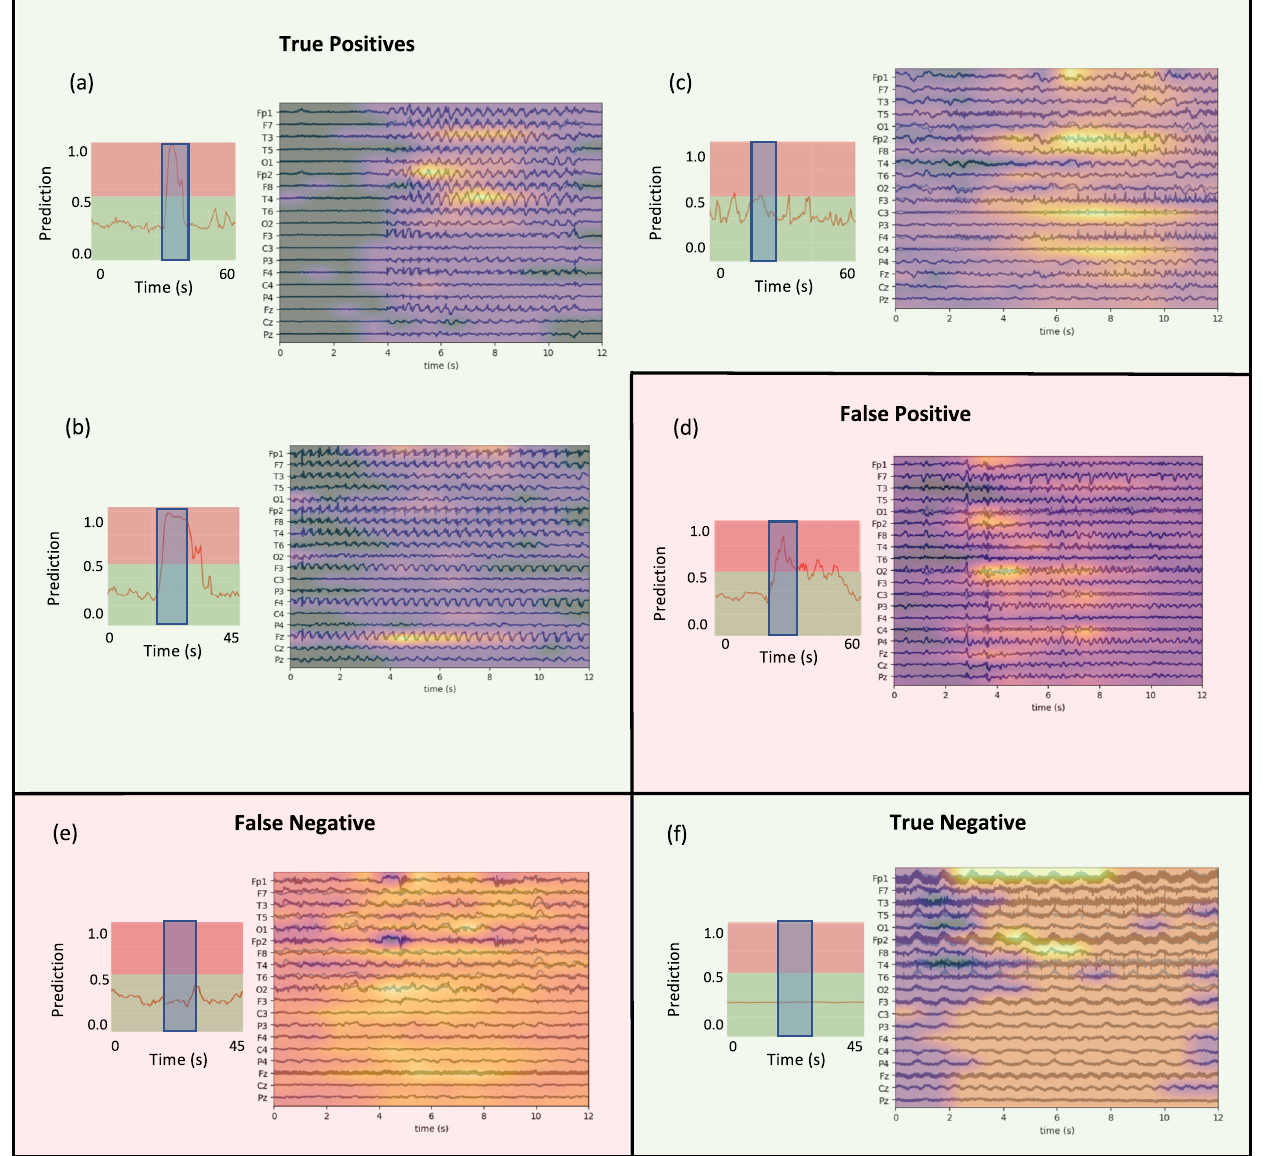
Fig. 6 Representative cases for true-positive, false-positive, false-negative, and true-negative. Green background represents successful cases, while the red background represents failure cases. The EEG clips are shown and overlaid with an occlusion map. To the left of the clip is a plot indicating the model prediction values in the vicinity of the clip, where the clip is highlighted by the blue rectangles. Note that occlusion map values are normalized within each image, meaning that values should not be compared across